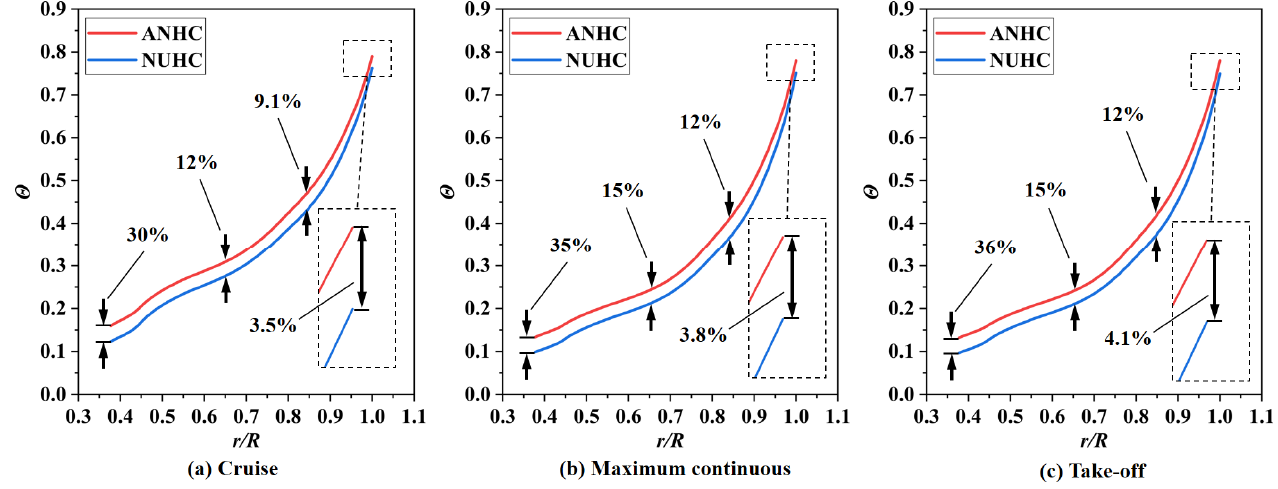
Figure 27. Dimensionless metal temperatures under ANHC and NUHC.